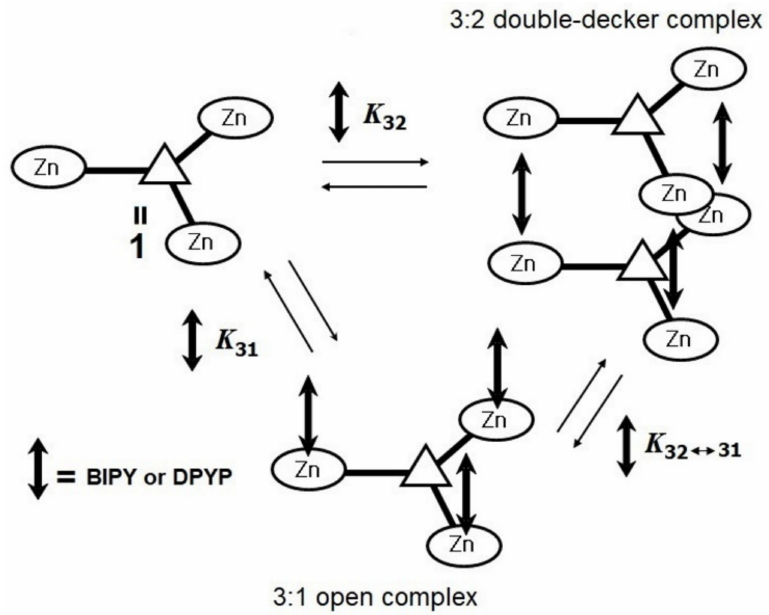
Scheme 3. Schematic representation of the species involved in the binding of Zn-trisporphyrin 1 with BIPY or